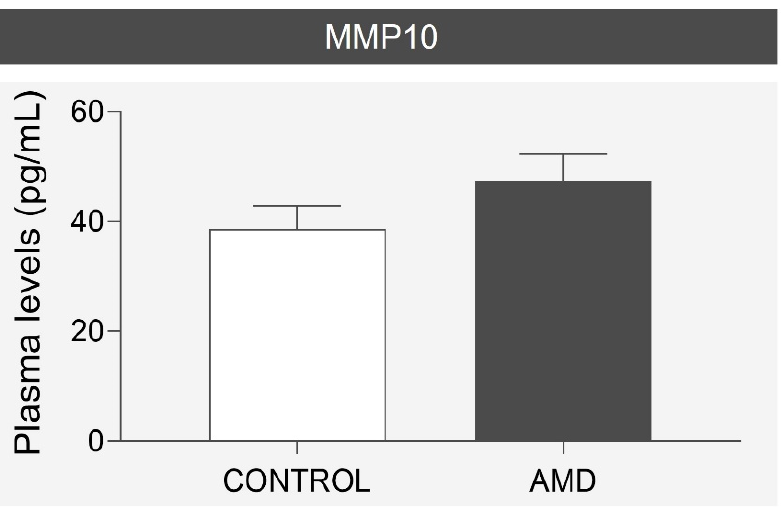
cohort. No statistically significant differences were found. AMD = age-related macular degeneration, Figure 5. Comparison of mean MMP10 plasma levels in the age ‐ and sex ‐ matched case ‐ control co ‐ MMP10 = Matrix metalloproteinase 10. hort. No statistically significant differences were found. AMD = age ‐ related macular degeneration, MMP10 = Matrix metalloproteinase 10.